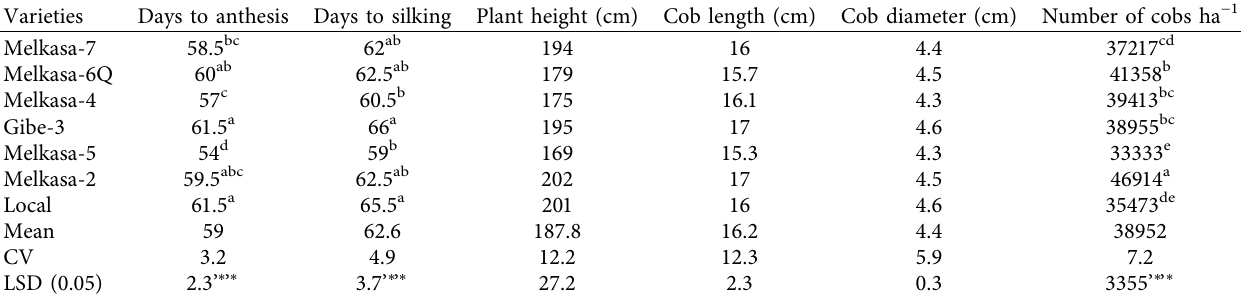
Table 5: Combined mean morphological and yield-related performance of open-pollinated maize varieties in 2017/18. Varieties